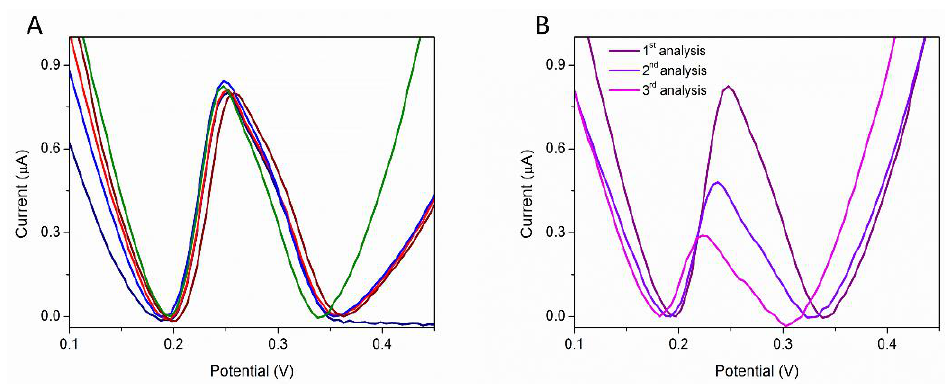
Figure 7. DPV analysis of 1 µ M PQS in H 2 SO 4 0.5 M: ( A ) on five different CNT-SPE and ( B ) successive analyses on the same CNT-SPE.